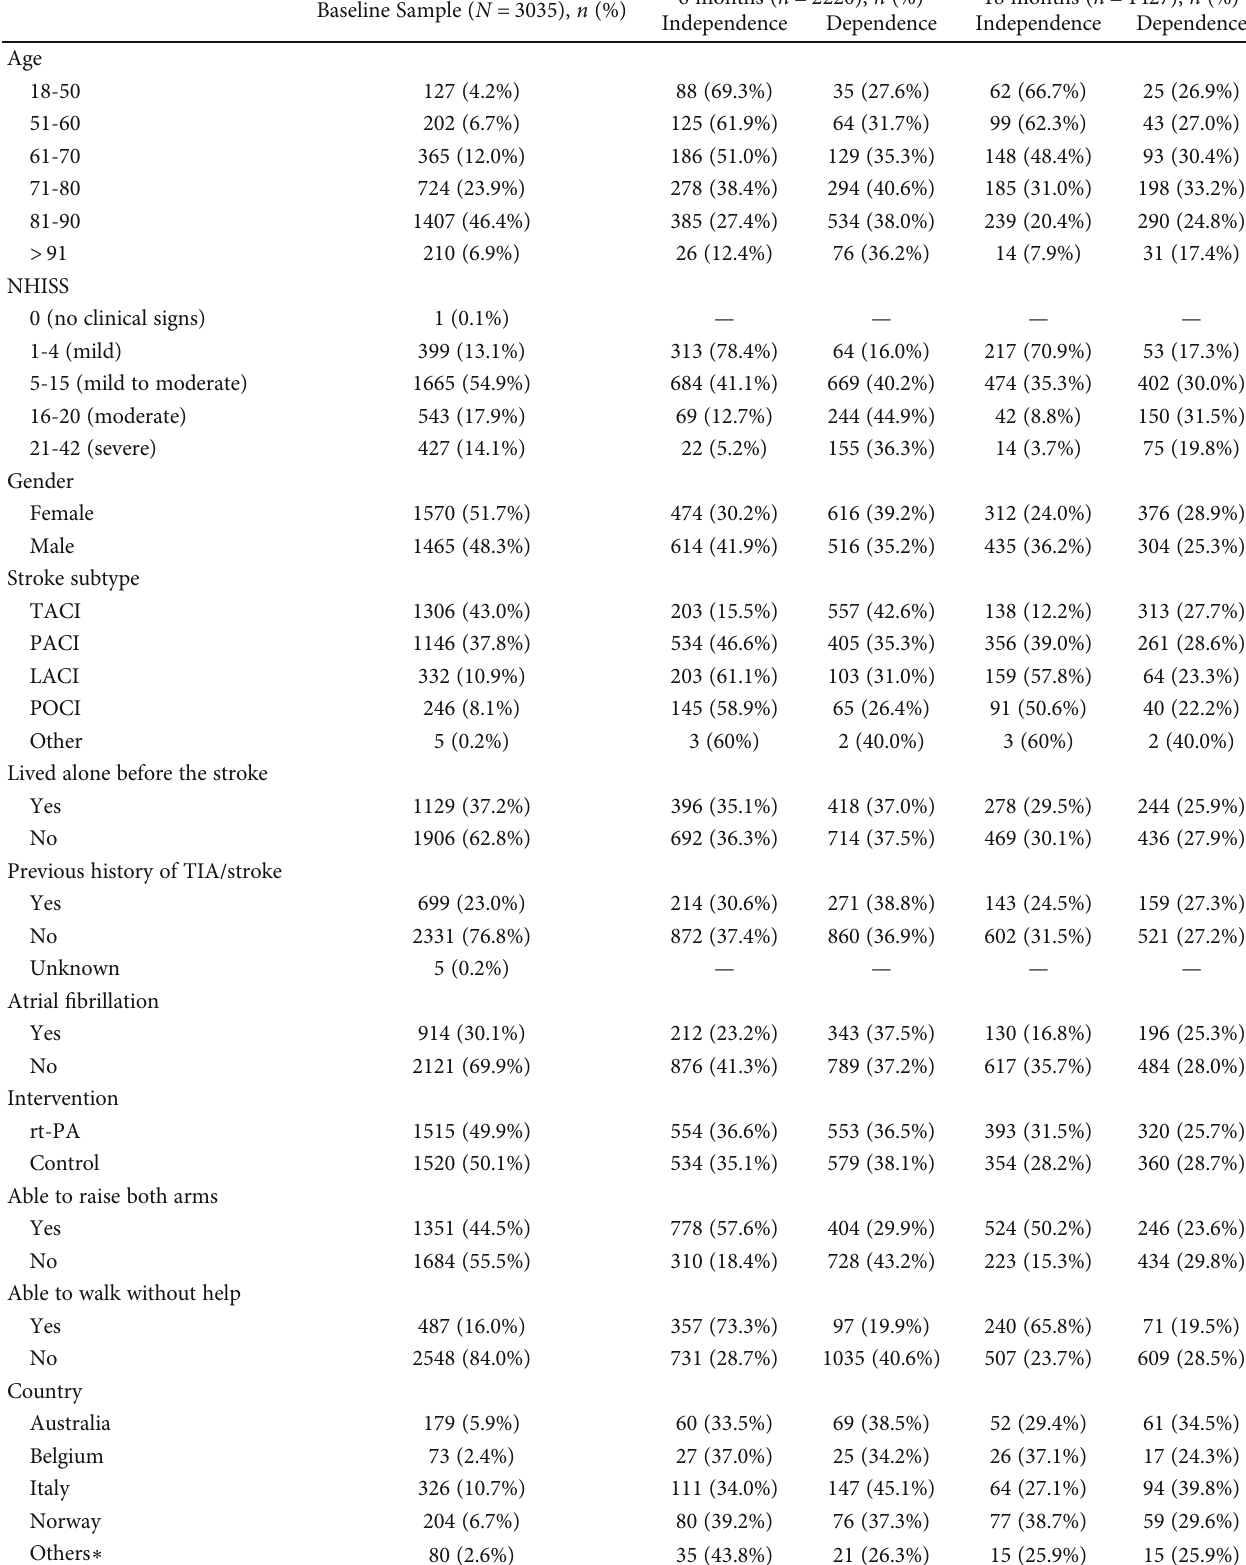
Table 3: Characteristics of the survival